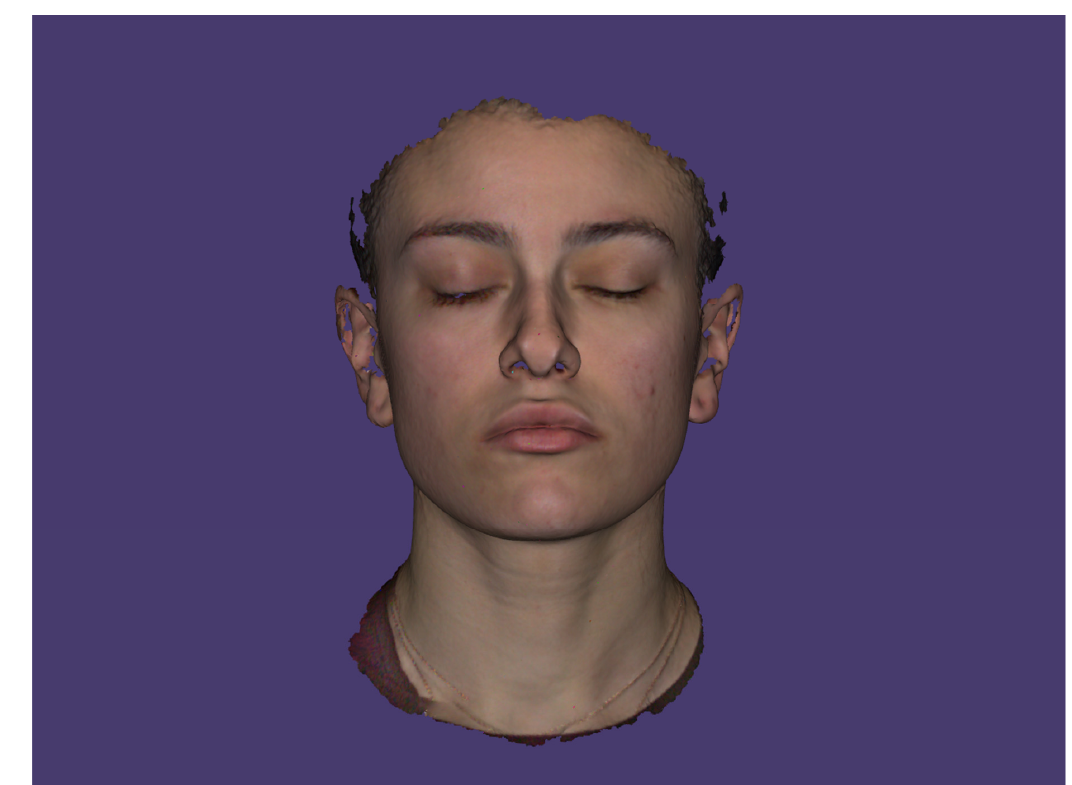
Figure 1. Digital impression of dental arches in occlusion with intraoral scanner.